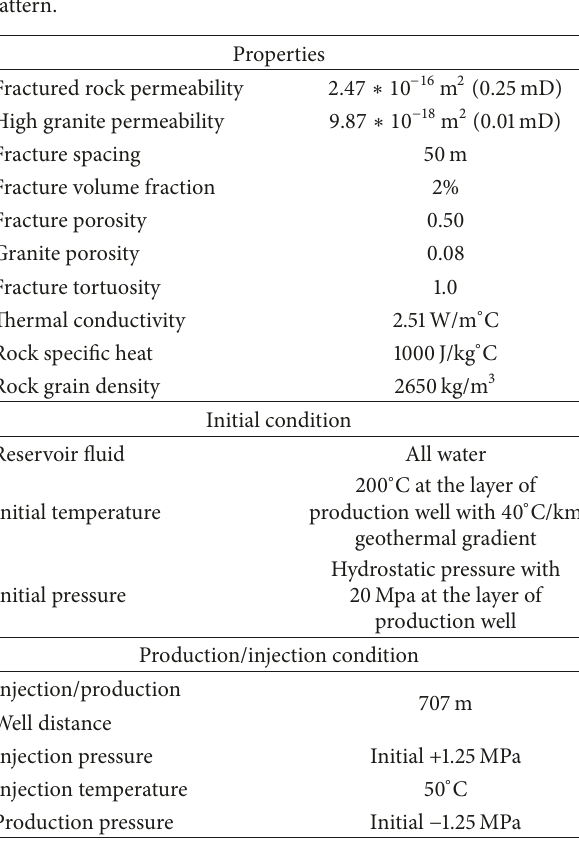
Table 2: Mineral assemblages of core samples from